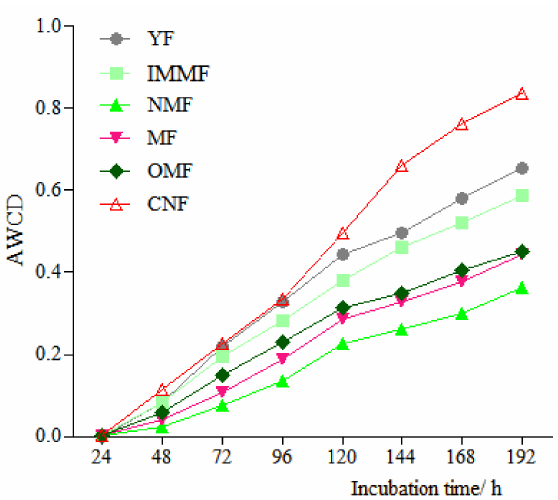
Figure 4. Changes of AWCD of soil microbial communities that utilized carbon sources in 323 differ- ent aged stands over time. AWCD is the average well color